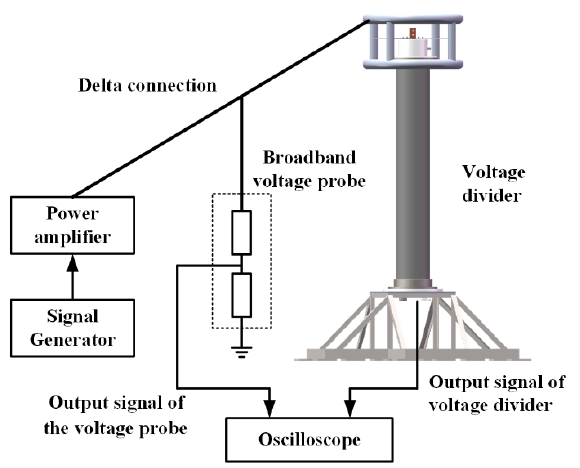
Figure 12. Schematic diagram of amplitude – frequency response test.